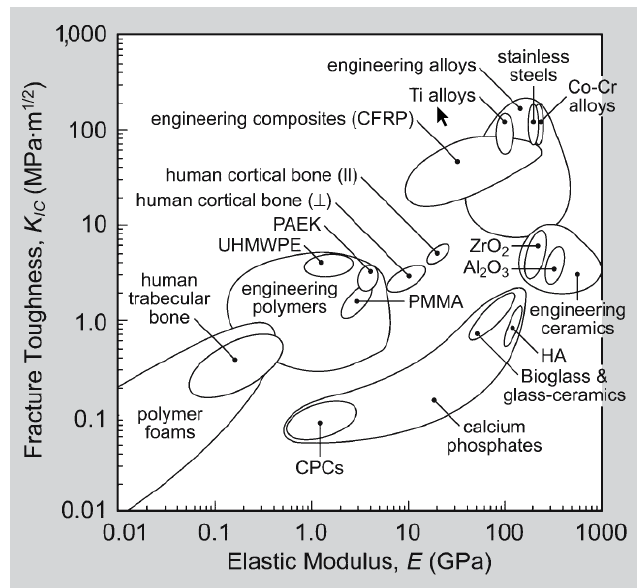
Figure 4. Ashby diagram correlating elastic modulus and fracture toughness of human bone and materials used in orthopedic implants. The mechanical properties of cortical bone are shown for parallel (II) and perpendicular ( ⏊ ) load applied to the anatomic longitudinal axis. Reproduced with permission from [58].